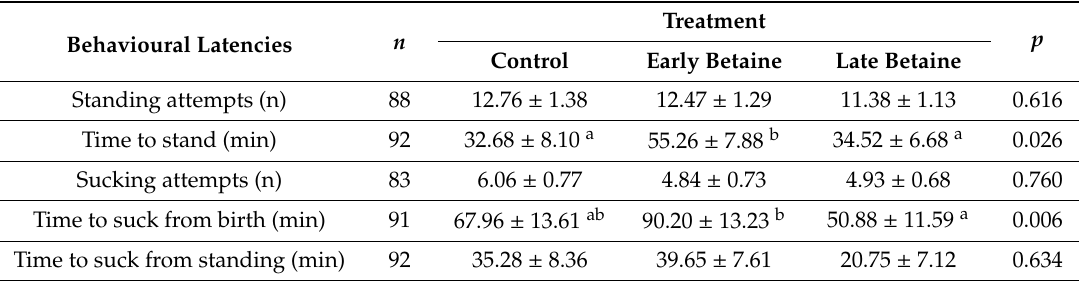
Time to suck from standing